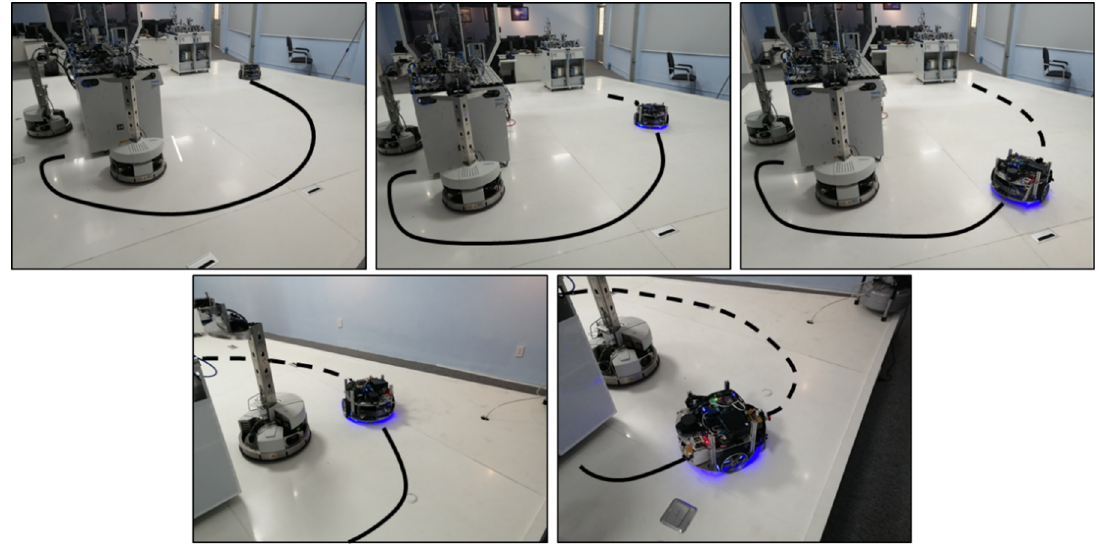
Figure 24. Snapshot series of the trajectory tracking performance of the robot in workspace.